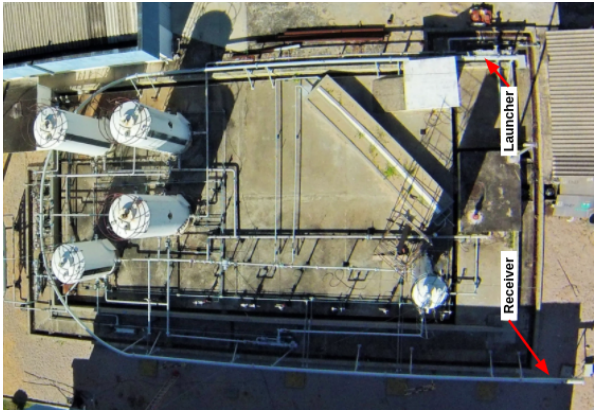
Figure 33. Top-view drawing of the testing pipeline.